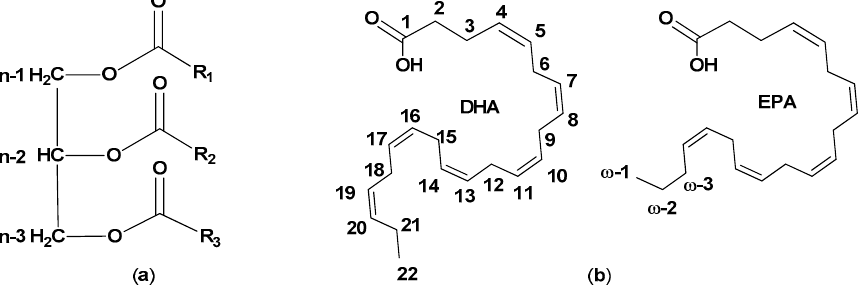
Figure 1. ( a ) Simplified structure of a triacylglycerol and ( b ) chemical structure of and docosahex- aenoic acid (DHA) and eicosapentaenoic acid (EPA).